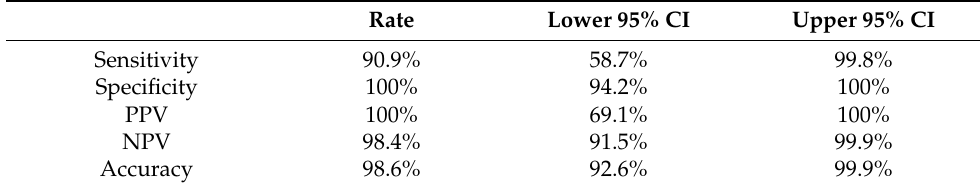
Table 3. Diagnostic performance of the MagUS